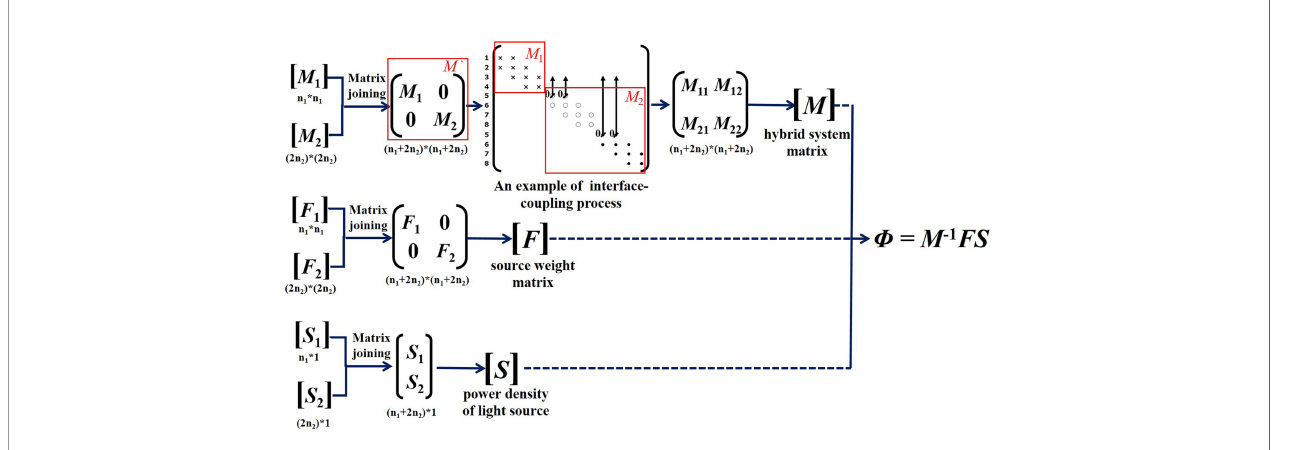
FIGURE 3 | Hybrid transport